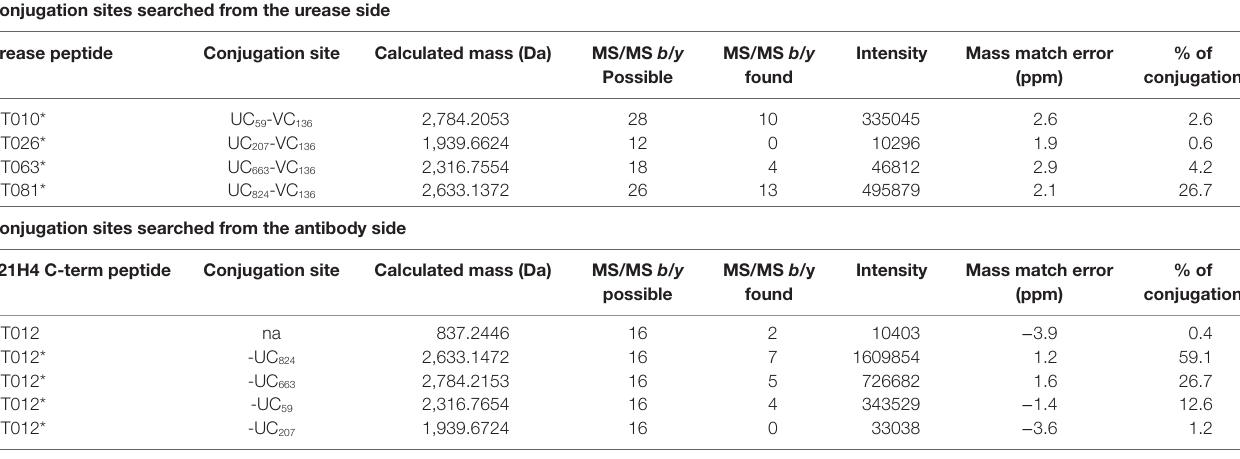
Thick boxes (also shaded blue) around sets of tryptic peptides indicate related groups of peptides used to calculate percentage of activation for each activation site. nd, not detected. *indicates the modified version of the TaBle 3 | ESI LC-MS E peptide mapping analysis: Identification of urease cysteine residues modified by V21H4-(PEG) 2 -Cys. conjugation sites searched from the urease side Urease peptide